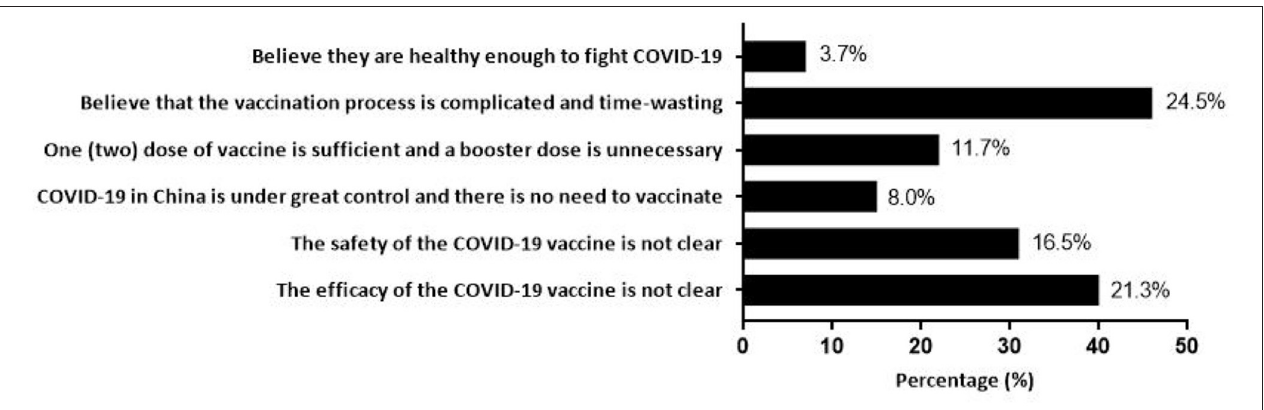
FIGURE 1 | Reasons for hesitating to give a booster dose of COVID-19 vaccine to children among 188 child caregivers with COVID-19 vaccination history.